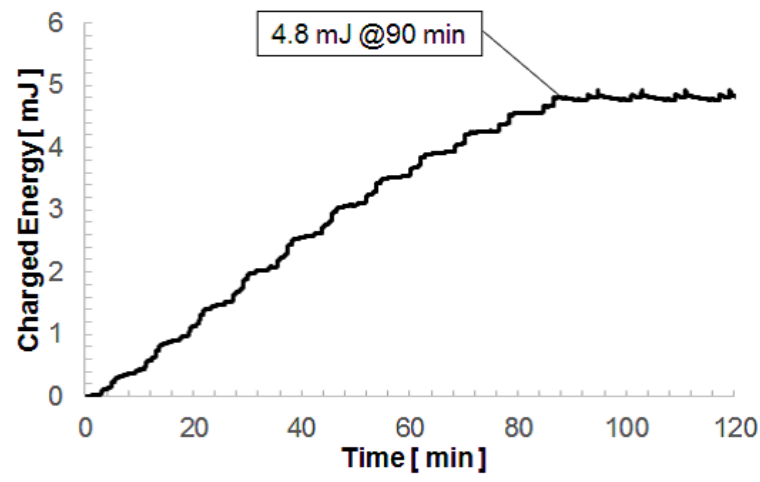
Figure 13. Voltage built up in a 44 µ F capacitor charged by the developed energy harvester driven by the highway viaduct